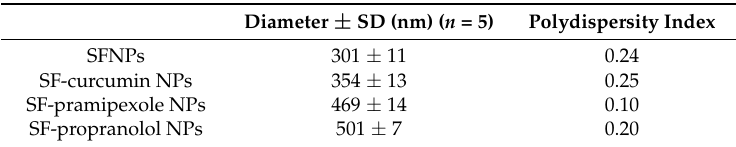
Table 3. Diameter of silk fibroin nanoparticles measured by dynamic light